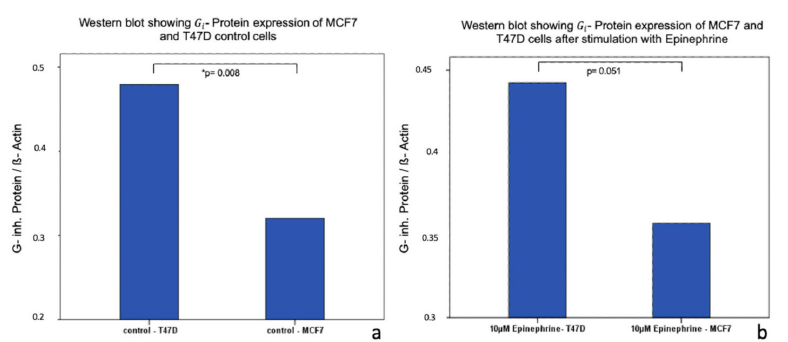
Figure 7. Western blot analysis of G i - protein expression in MCF7 and T47D cells after stimulation with epinephrine. ( a ) Bar chart of G i - protein expression in T47D and MCF7 control cells. There is a significant lower of expression of G i - protein ( p = 0.008; * significant p -value). ( b ) Bar chart of G i - protein expression in MCF7 and T47D cells after incubation with 10 µ M epinephrine have a tendency for a higher expression of G i - protein in T47D cells after stimulation than in MCF7 cells after stimulation with 10 µ M epinephrine ( p =